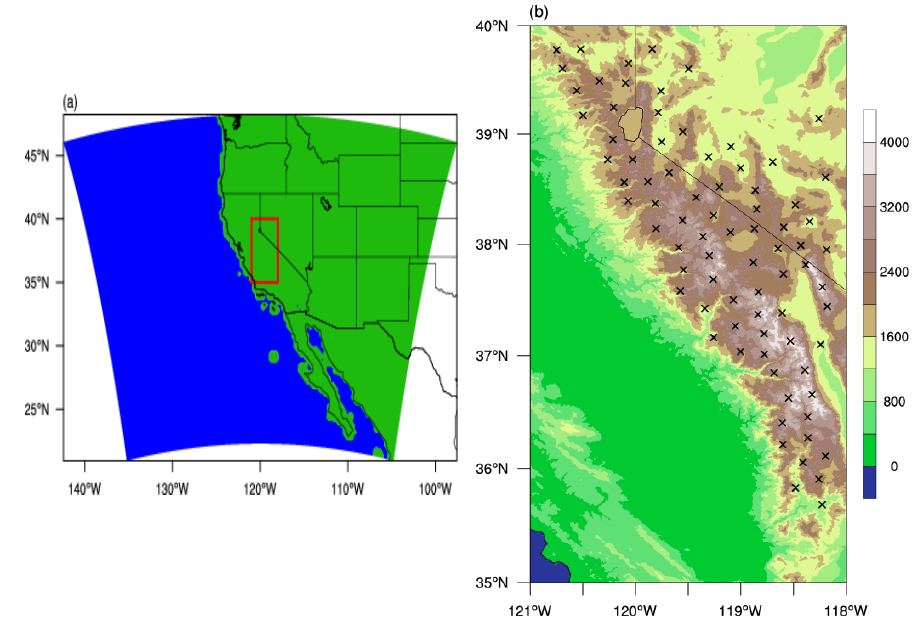
Fig. 1. (a) The domain of the western United States, where the red box denotes the study region over the Sierras. (b) The topography for the study region using the digital elevation model (DEM) at a resolution of 1km. The scale on the right is in units of meter. The x’s represent 80 sub-regions with a resolution of 20km from which the parameterization data involving 3-D radiative transfer was derived (Lee et al.